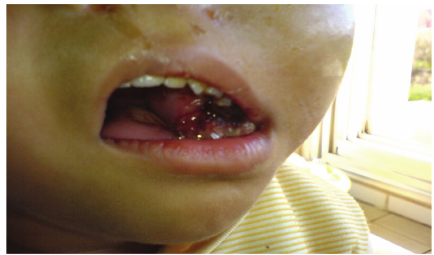
Figure 5: Photograph taken in the second hospitalisation shows the recurrence of the